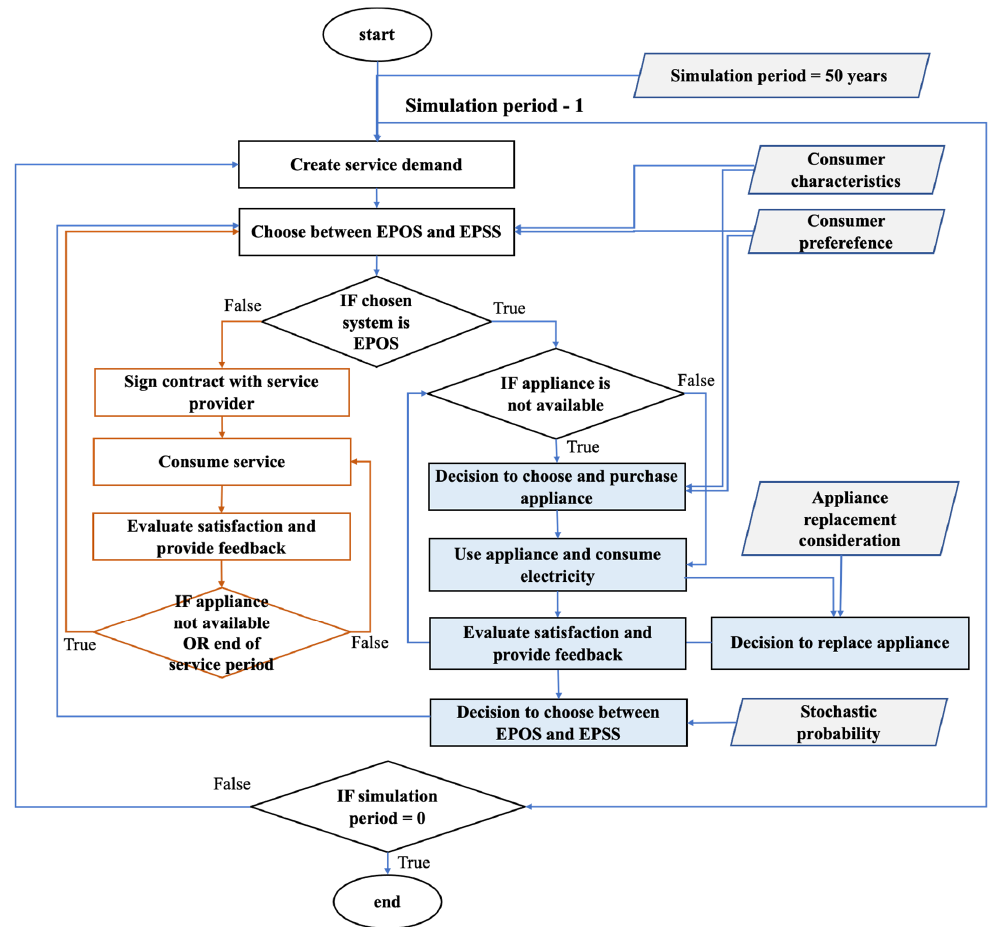
Figure A1. Consumer decision flow.